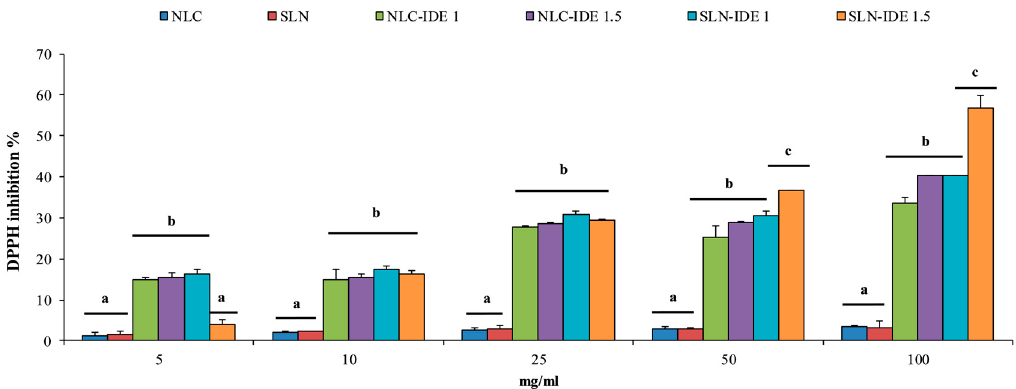
Figure 4. Antioxidant activity of IDE-loaded SLN and IDE-loaded NLC (5-100 mg/mL) indicated as percent (%) of DPPH radical inhibition. The letters b and c indicate, for each concentration, a significant difference ( p < 0.05.) between the samples loaded with 1% or 1.5% w/w of idebenone (IDE) and the samples of unloaded SLN and NLC (indicated with the letter a). NLC = unloaded nanostructured lipid carrier; SLN = unloaded solid lipid nanoparticles; NLC-IDE 1 = NLC loaded with IDE 1% w/w; SLN-IDE 1 = SLN loaded with IDE 1% w/w; NLC-IDE 1.5 = NLC loaded with IDE 1.5% w/w; SLN-IDE 1.5 = SLN loaded with IDE 1.5% w/w.